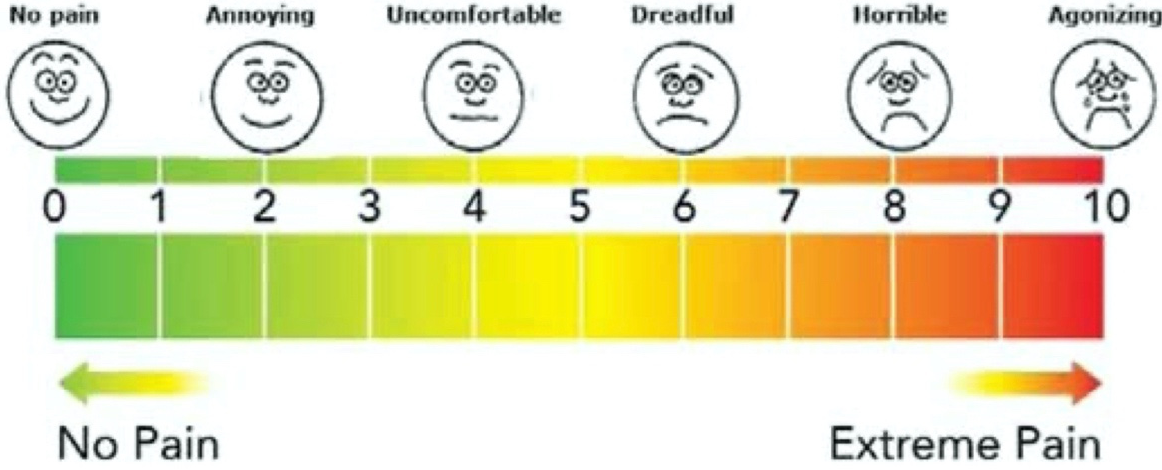
Figure 3. Sensitivity score scale table.